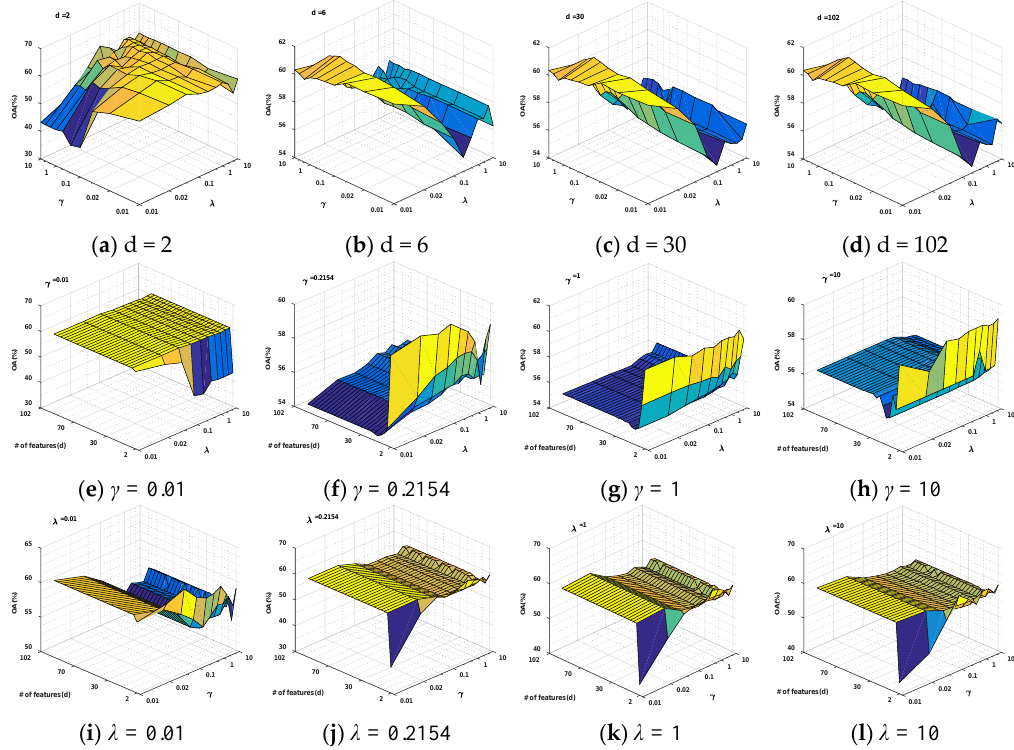
Figure 10. OA versus the number of features d, the SVM parameter γ , and the regularization factor λ of JTM for ROSIS data sets (Left portion → Right portion). ( a ) OA versus γ and λ , d = 2; ( b ) OA versus γ and λ , d = 6; ( c ) OA versus γ and λ , d = 10; ( d ) OA versus γ and λ , d = 102; ( e ) OA versus λ and d, γ = 0.01; ( f ) OA versus λ and d, γ = 0.2154; ( g ) OA versus λ and d, γ = 1; ( h ) OA versus λ and d, γ = 10; ( i ) OA versus γ and d, λ = 0.01; ( j ) OA versus γ and d, λ = 0.2154; ( k ) OA versus γ and d, λ = 1; ( l ) OA versus γ and d, λ = 10.